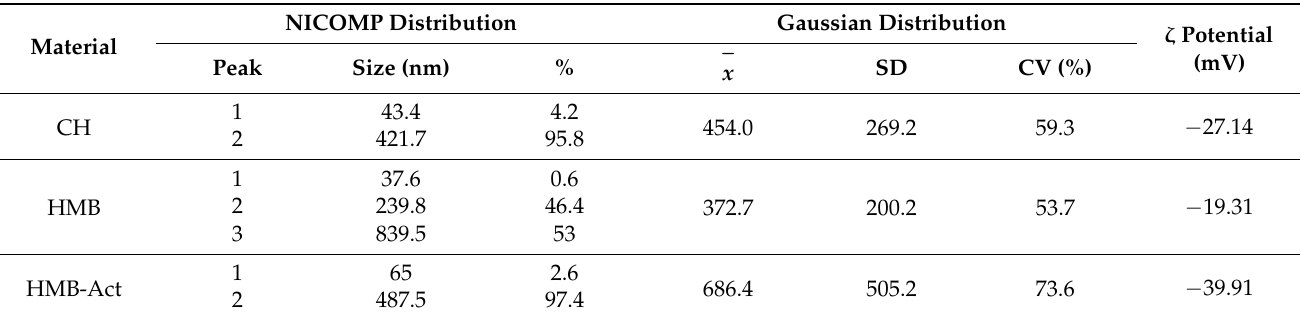
Table 2. Particle size and ζ potential.